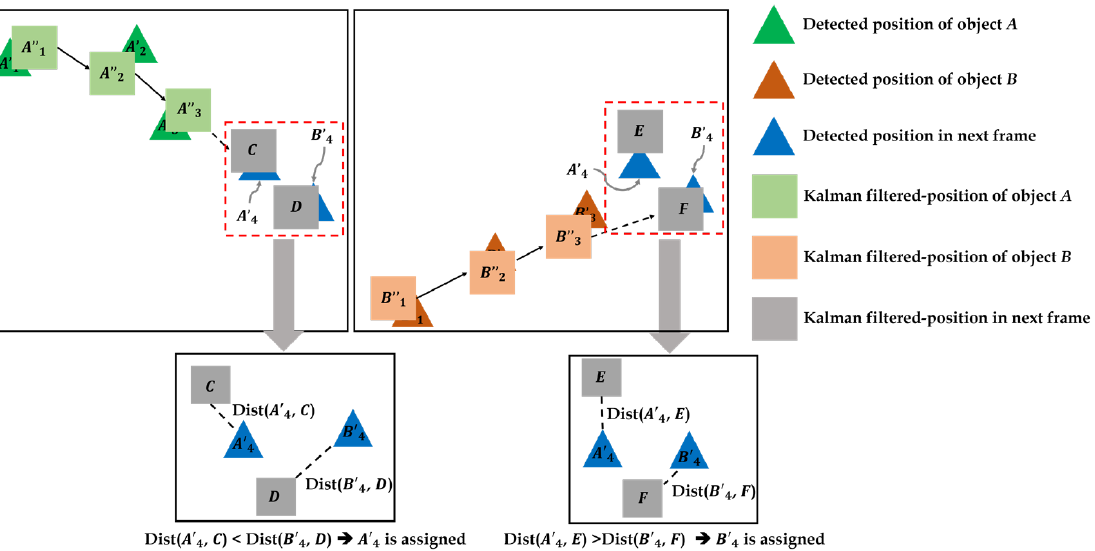
Figure 5. Process of object tracking and indexing algorithm for object A ( left ) and object B ( right ).